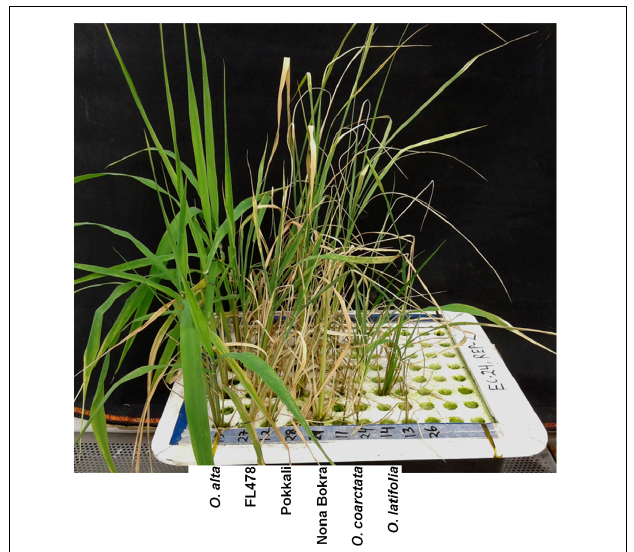
FIGURE 2 | Seedlings phenotype of the three highly tolerant wild species with the tolerant check lines after 10 days of 240 mM NaCl treatment. Scale bar = 5 cm.